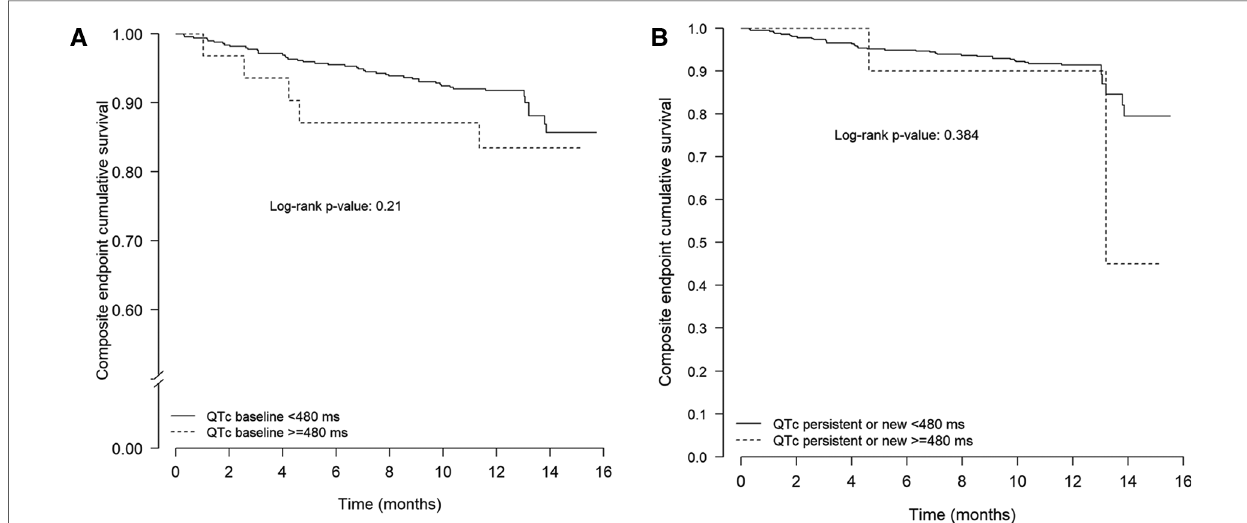
FIGURE 2 Kaplan – Meier curves for the composite endpoint (death or hospital readmission or new arrhythmia) in 421 COVID-19 survivors according to the presence or absence of persistent or new prolonged QTc ( A ) or persistent or new prolonged QTc at 7 months ( B ). COVID-19, coronavirus disease 2019.